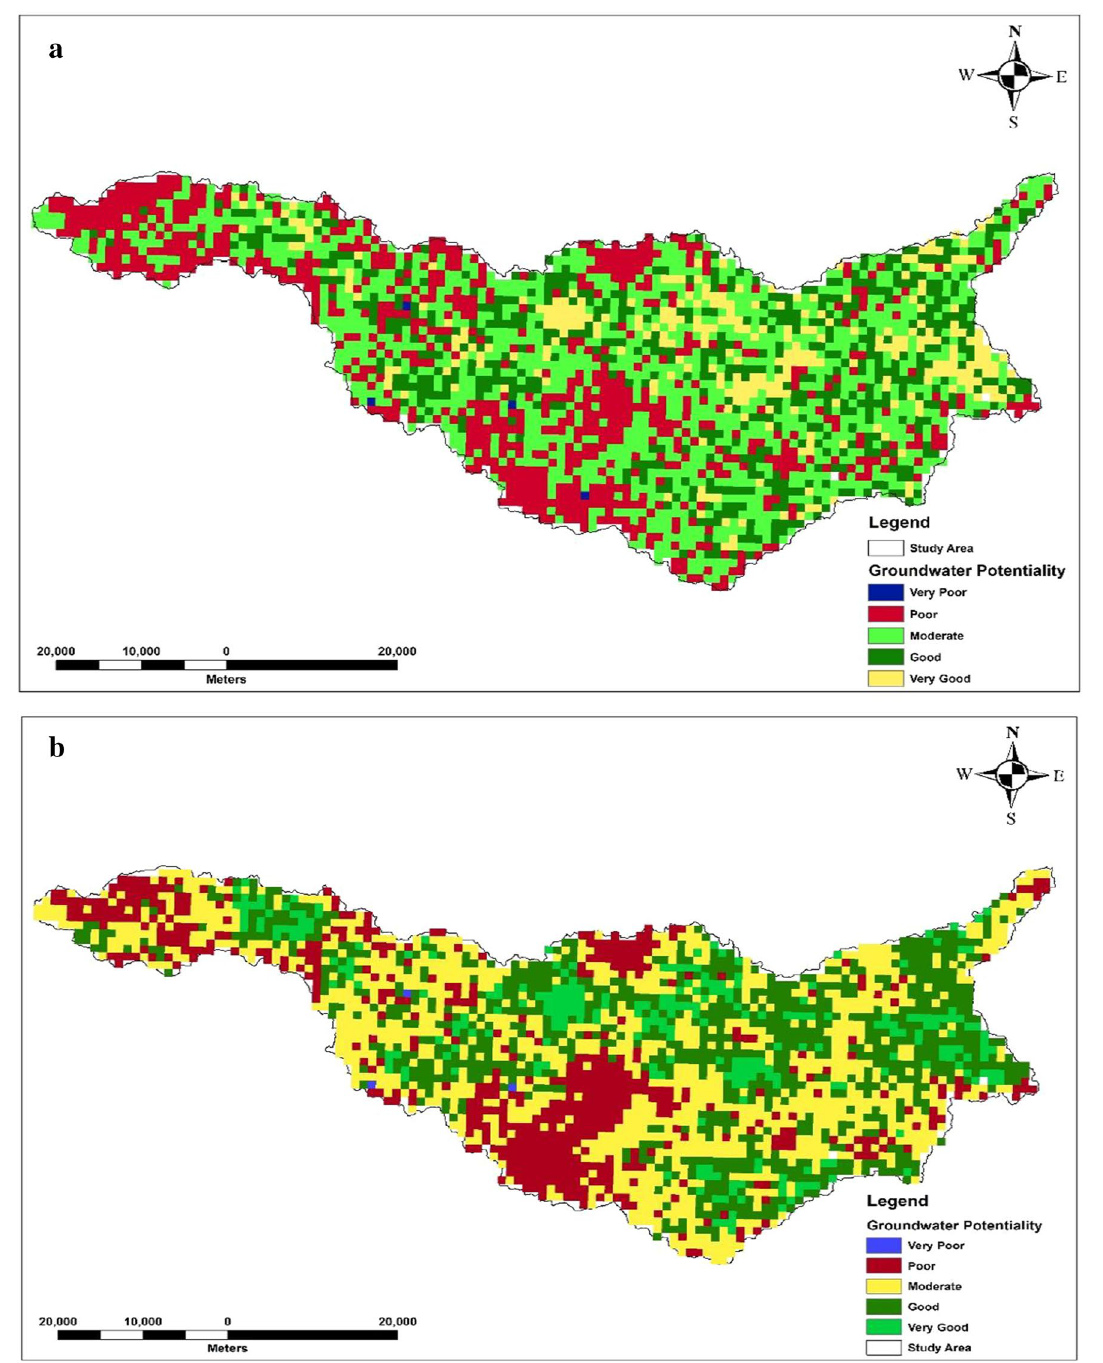
Fig. 5 a GPZ map based on AHP technique, and b GPZ map based on MIF